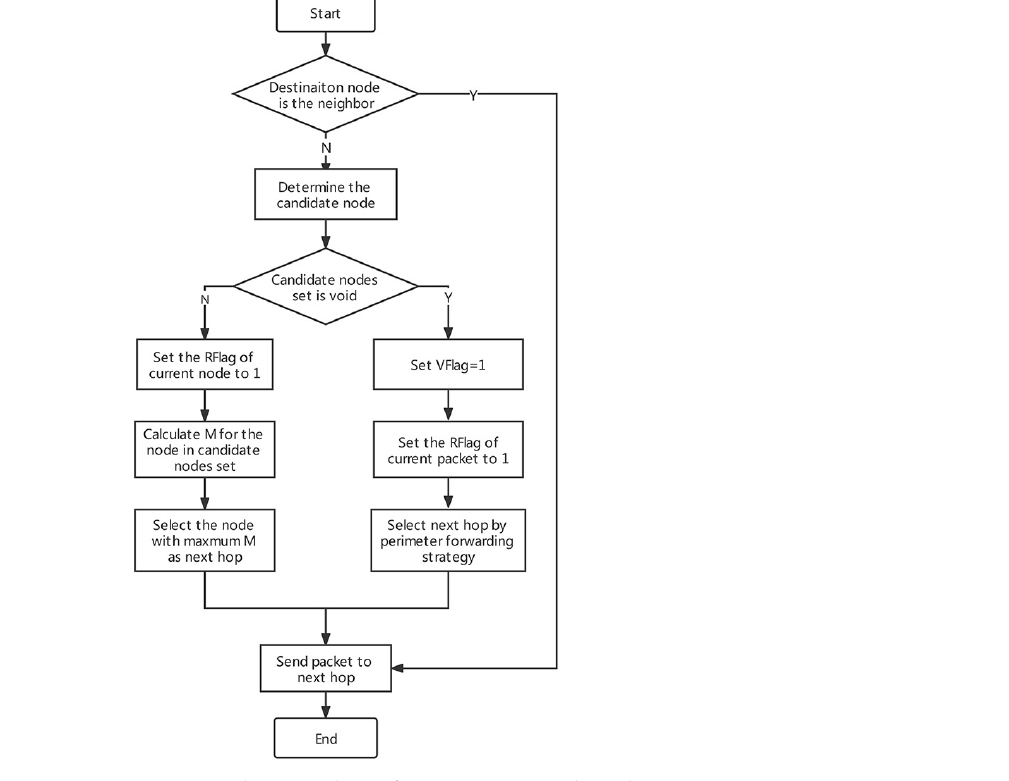
Figure 9. The procedure of GS-EERA main algorithm. Algorithm 2